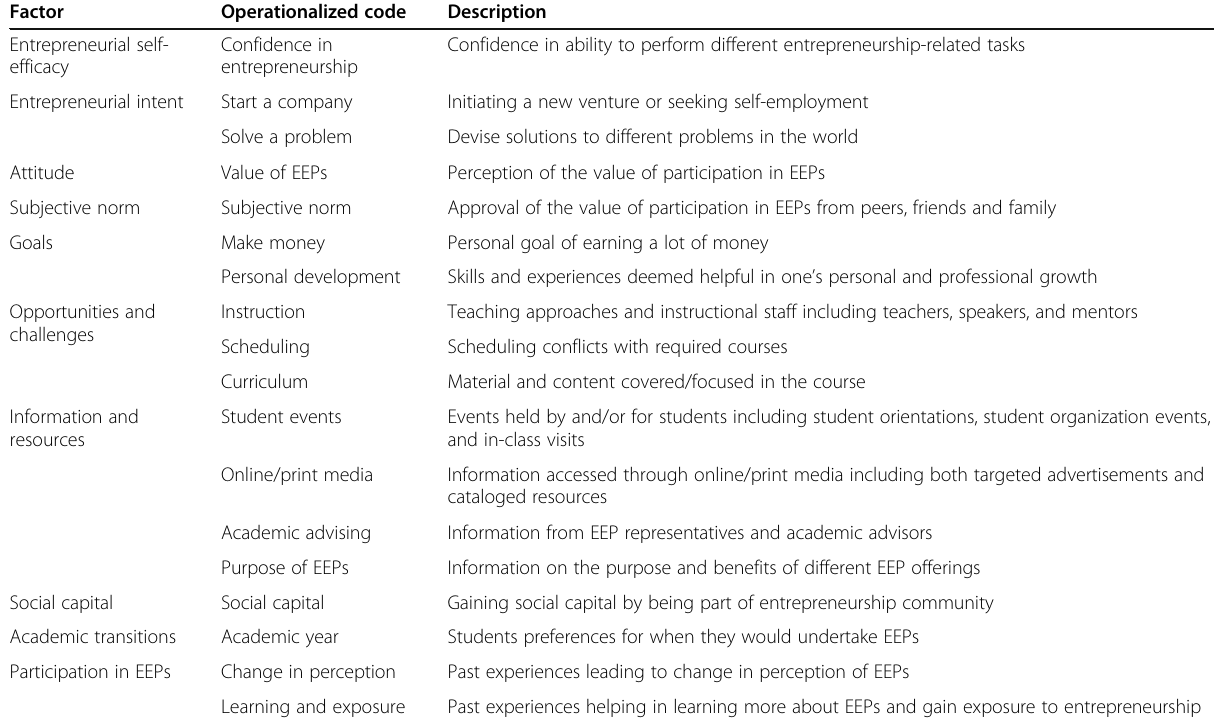
Table 2 Description of